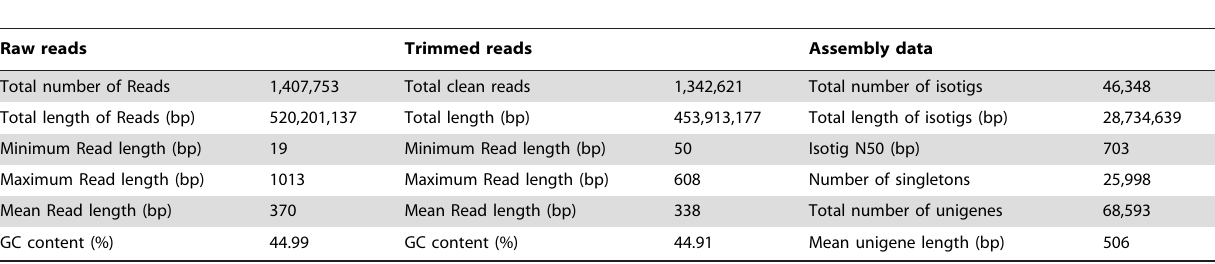
Table 1. Raw reads and assembled data information by transcriptome sequencing.